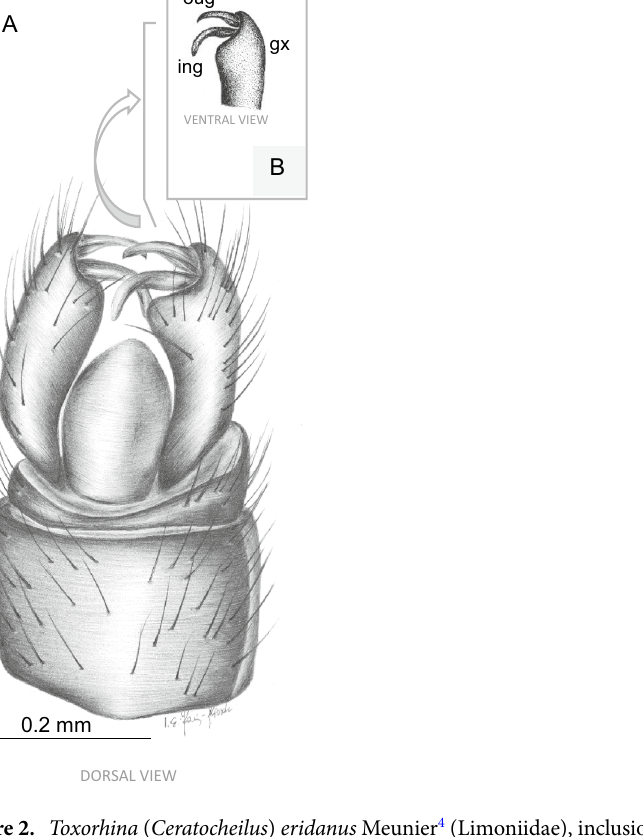
Figure 2. Toxorhina ( Ceratocheilus ) eridanus Meunier 4 (Limoniidae), inclusions in Baltic amber, No. K2532 (male) (coll. Klebs), specimen from University of Göttingen: ( A ) drawing of hypopygium, dorsal view (reconstruction); ( B ) drawing of tip of gonocoxite without spine and gonostyles, ventral view (reconstruction). gx—gonocoxite; ing—inner gonostylus; oug—outer